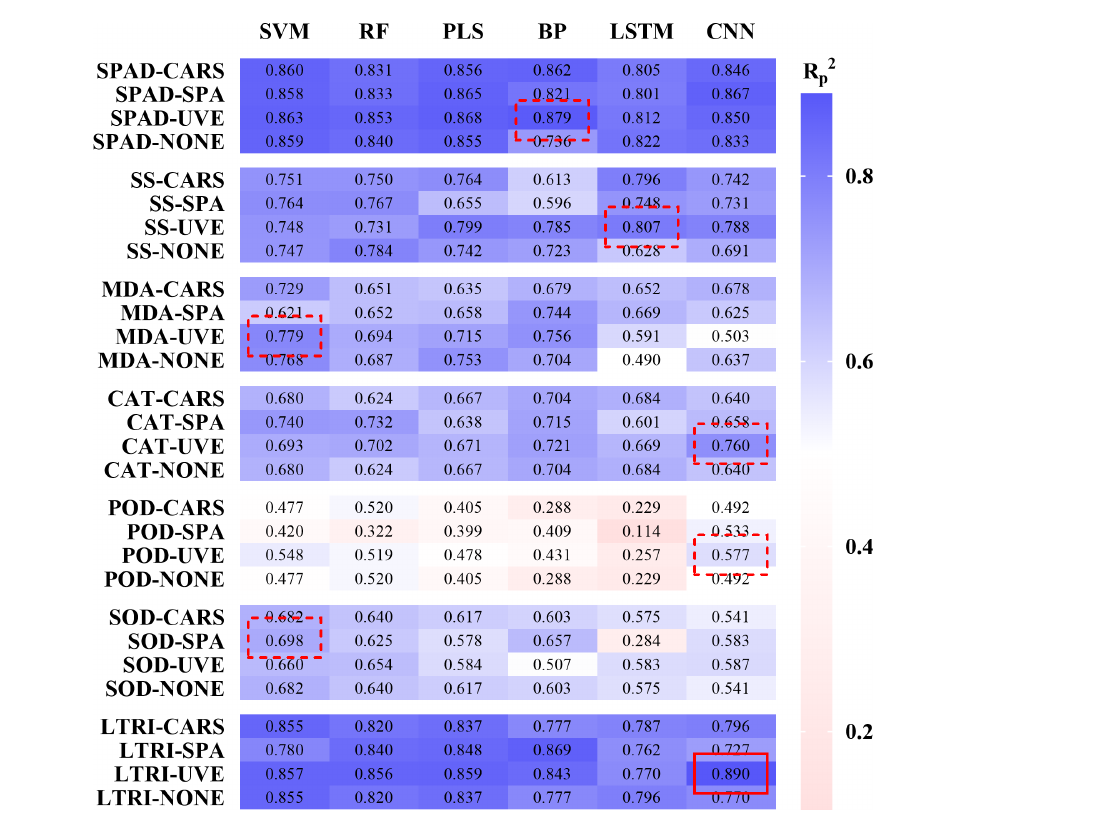
FIGURE 5 Modeling results of low temperature-induced components and low temperature injury degree of tea